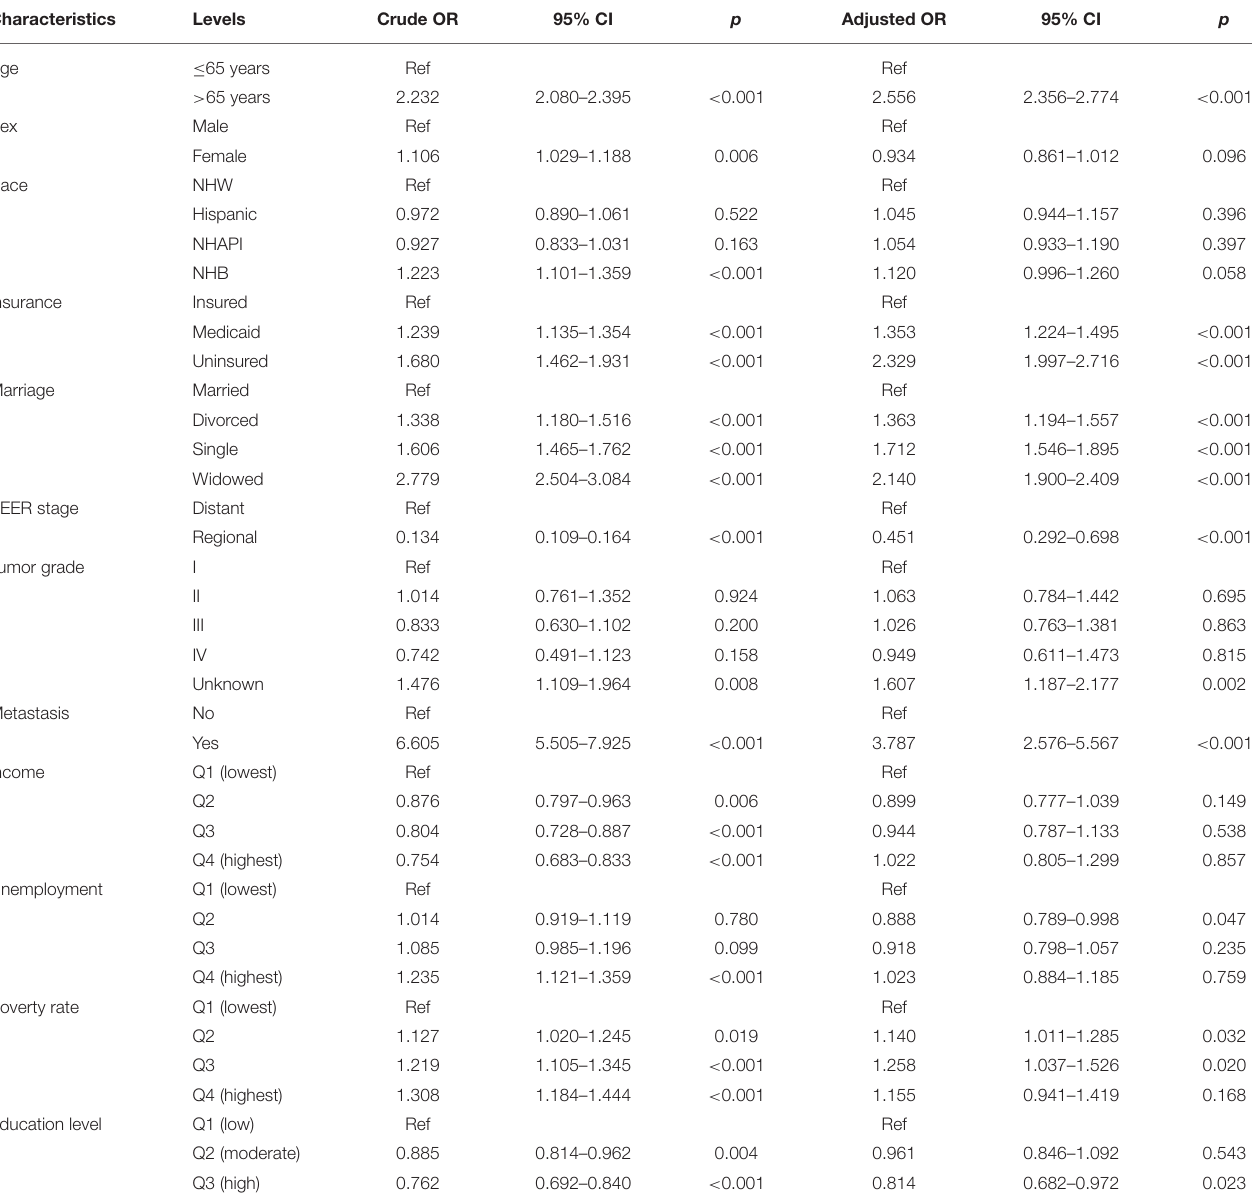
TABLE 5 | Univariate and multivariate logistic regression analysis of no treatment (no chemotherapy or surgery) in AJCC stage IV patients.